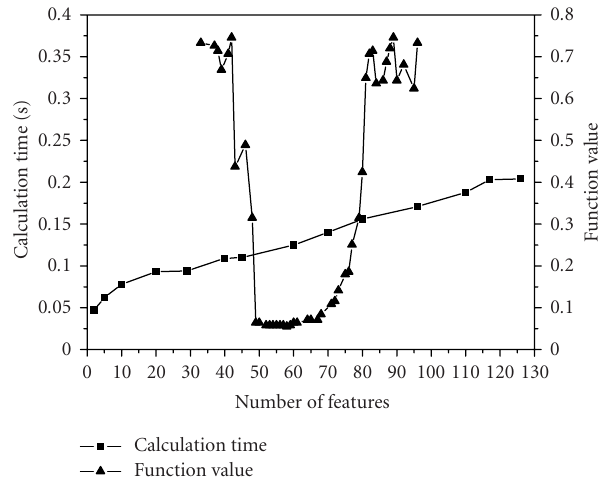
Figure 11: The relationships between calculation time, objective function value, and the number of features under no-load condi-